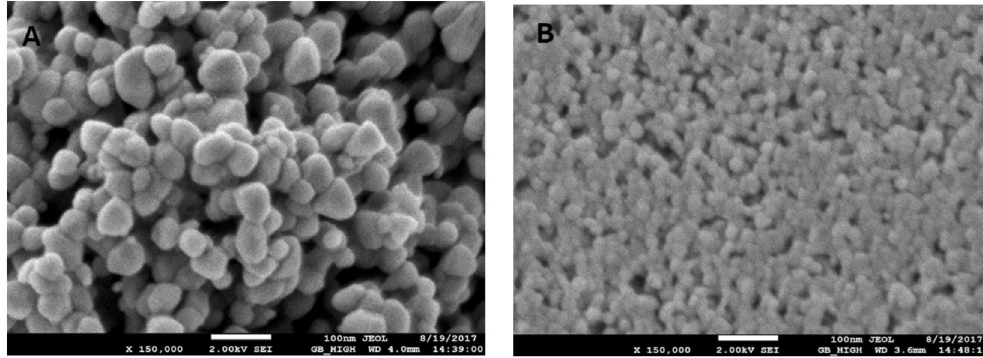
Figure 4. FE-SEM images (scale; 100 nm, mag; x 150,000) for ( A ) ZnO (pure) ( B ) 0.5 wt%